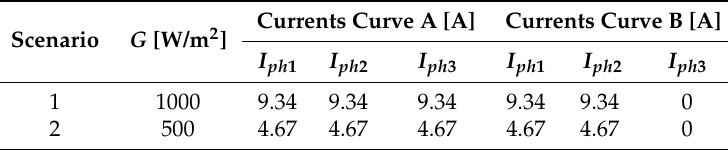
Figure 8. Circuital implementation in Simulink of a PV module formed by three submodules ( N m = 3). Table 1. Irradiance scenarios and I ph values used in the